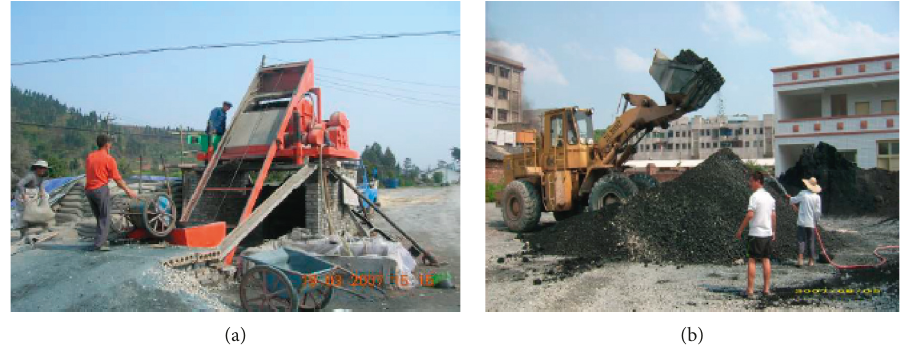
Figure 17: Cement-treated mixture mixing (a). Lime-treated mixture mixing (b).